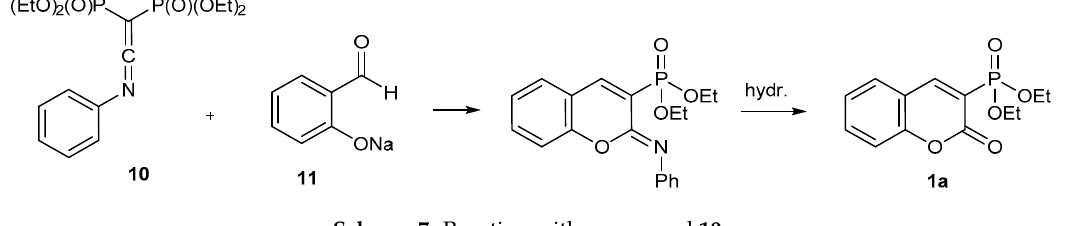
Table 2. Results from the reactions of 2-diethoxyphosphorylacrylates 12 with substituted phenols or naphthols 13 in the presence of strong